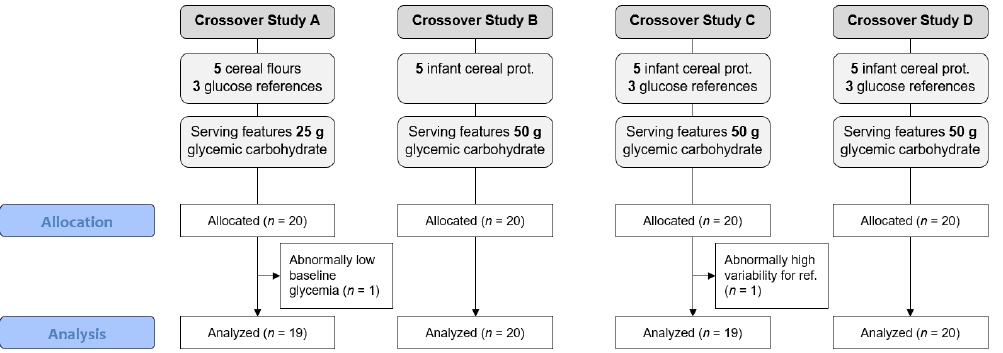
Figure 1. Flow chart showing the features of the four studies performed between 2016 and 2019. All samples were reconstituted in 250 mL water.